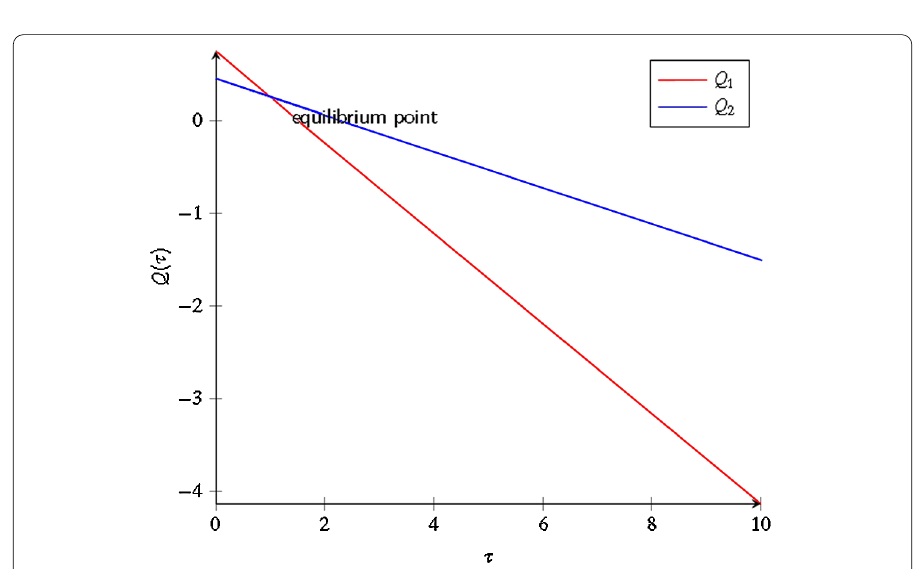
Figure 2 Example 2; The local entropy solution for a function α = 0.99, Q ( τ ) = ( Q 1 , Q 2 ) with respect to τ . We suppose C (1) = 0.499, C (2) = 0.2